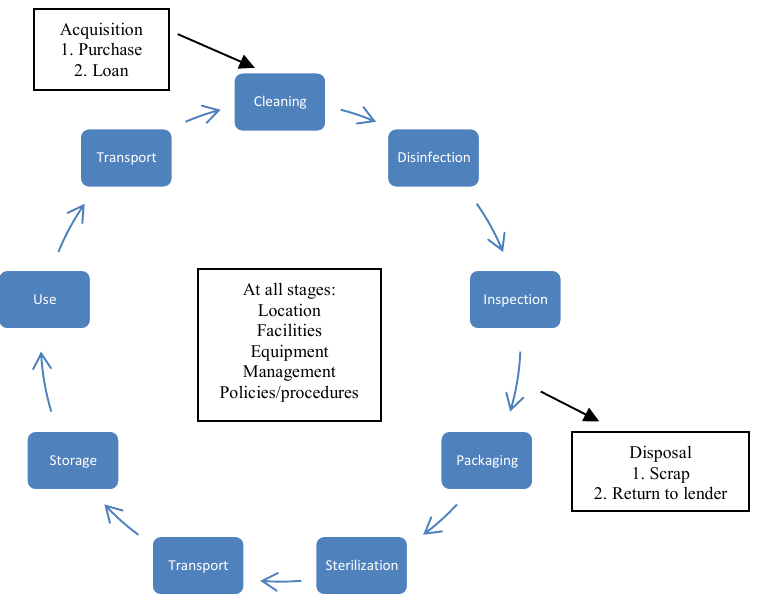
Fig. 1. Standard sterilization protocol for reusable instruments